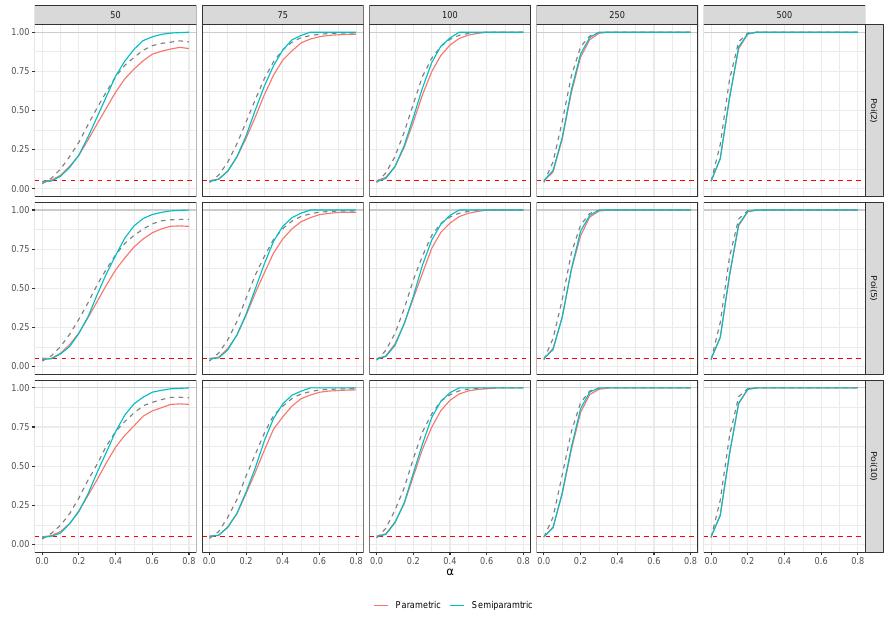
Figure 1. Empirical power of the bootstrap-based score test under Poisson DGP. The black dashed line is the empirical power of the asymptotic test, while the red dashed line represents the nominal level of